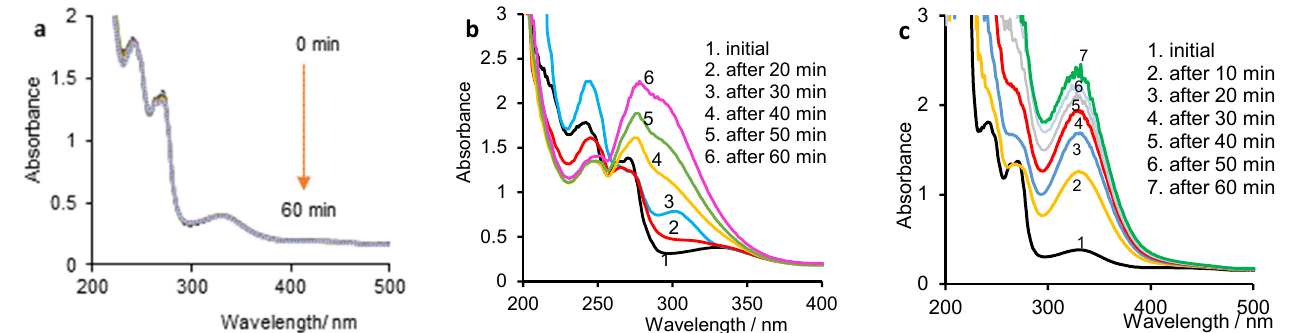
Figure 6. UV-Vis spectra recorded before and during constant current density electrolysis, every 10 min, for one hour: ( a )—in 0.1 mol L − 1 NaF solution containing 6.65 × 10 − 5 mol·L − 1 VK (NaF–VK); ( b )—in 0.1 mol L − 1 NaCl solution containing 6.65 × 10 − 5 mol·L − 1 VK (NaCl–VK); ( c )—in 0.1 mol L − 1 NaBr solution containing 6.65 × 10 − 5 mol·L − 1 VK (NaBr–VK).